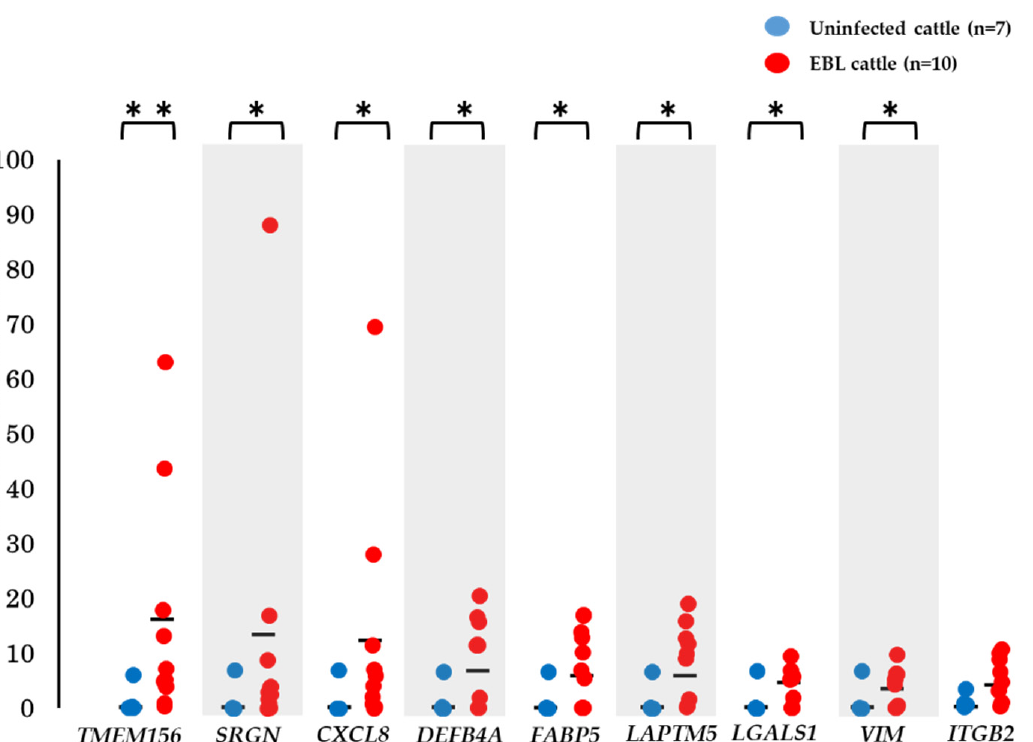
Figure 4. Validation of mRNA biomarker candidates using newly collected milk sEVs, not used in microarray analysis. For evaluation of the utility of 9 mRNAs for biomarker candidates, qPCR was carried out using mRNA in milk sEVs from 7 uninfected and 10 EBL cattle. TMEM156 , SRGN , CXCL8 , DEFB4A , FABP5 , LAPTM5 , LGALS1 , and VIM were significantly higher in milk sEVs from EBL cattle than in those from uninfected cattle. Quantity of ITGB2, though higher in the infected group, was not significantly different between the groups. The mean of relative quantities of mRNA is shown as a horizontal bar. (**, p < 0.01; *, p <